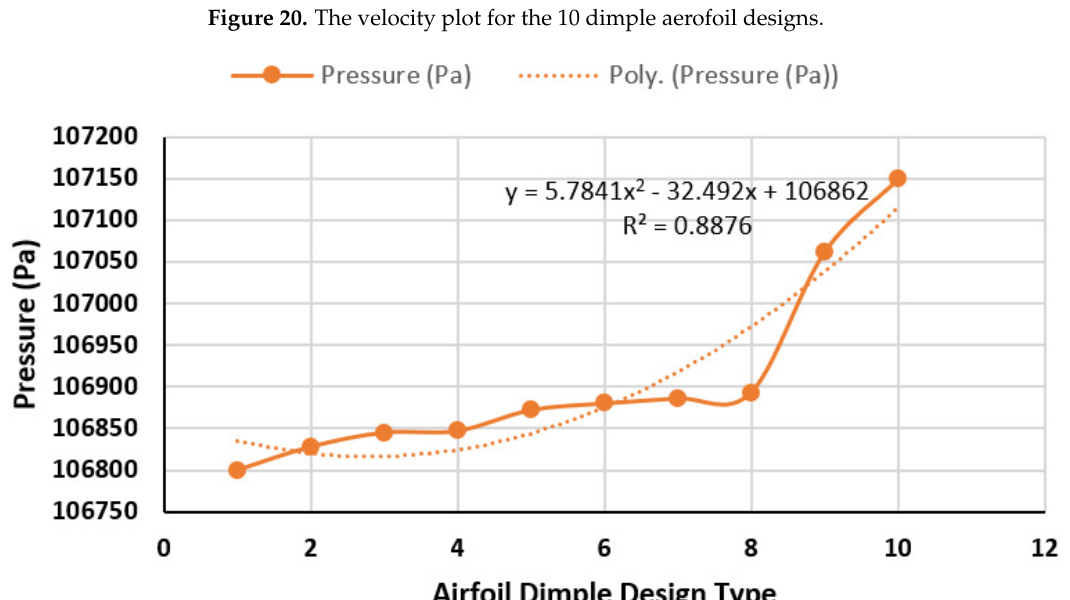
Figure 21. The pressure plot for the 10 dimple aerofoil designs.